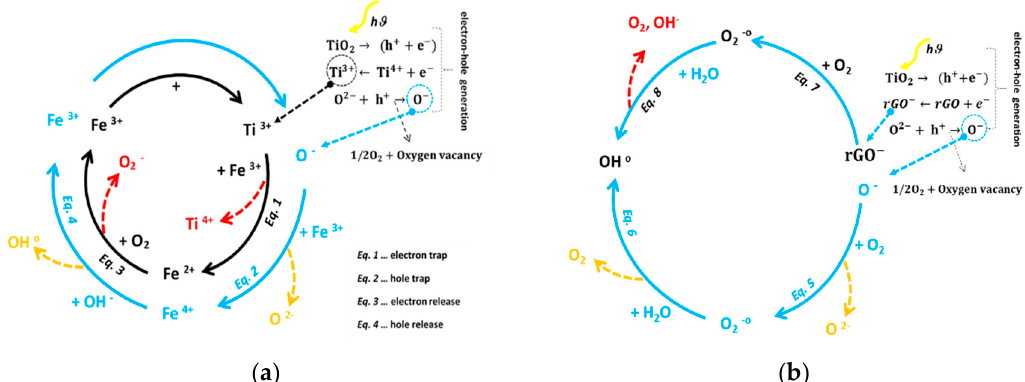
Figure 10. The proposed mechanisms for turning to hydrophilicity in TiO 2 affected by ( a ) γ -Fe 2 O 3 , ( b ) rGO.